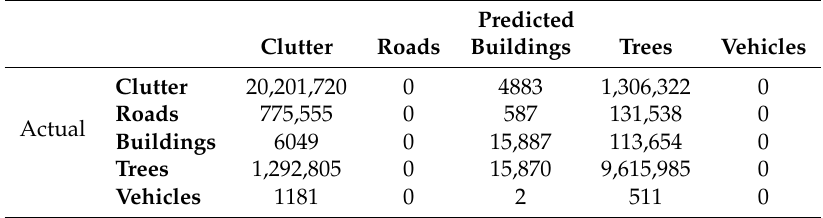
Table A10. Confusion matrix for the decision tree model that is trained on hand-crafted coordinates features.